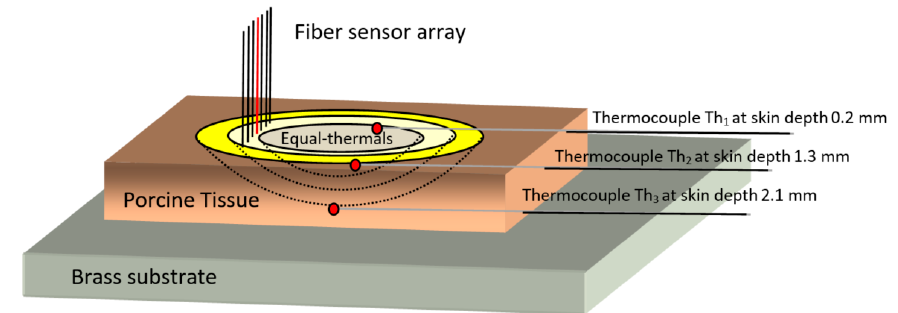
Figure 6. Top view schematic representation of experimental arrangement of the porcine tissue in brass substrate together with thermocouples.